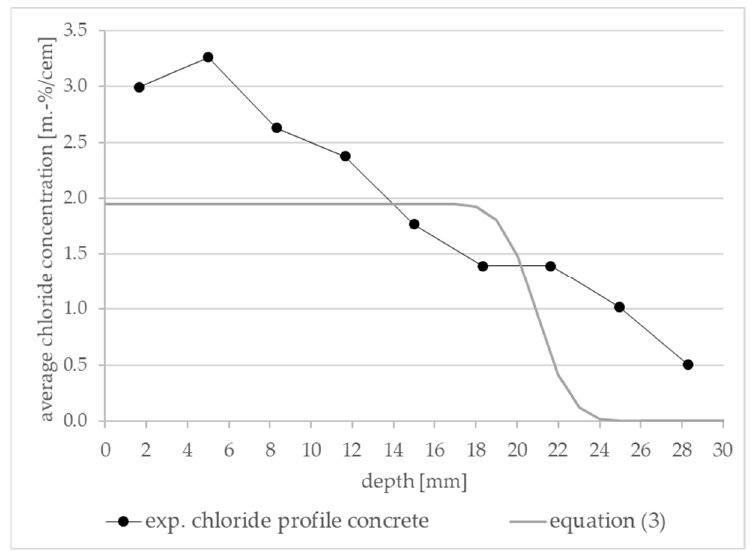
Figure 1. Comparison of an exemplary experimental chloride profile (own investigation of a concrete sample) and the theoretical prediction based on Tang [2], Equation (3).